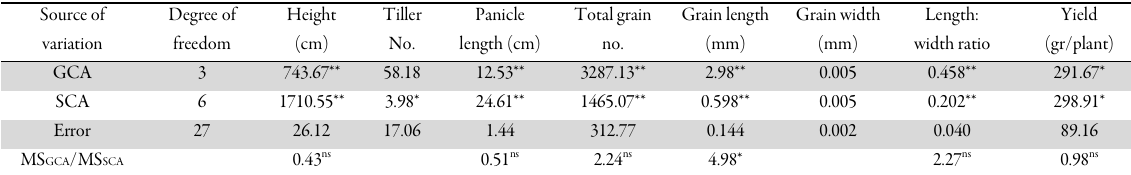
Table 3. Analysis of variance for combining ability Source